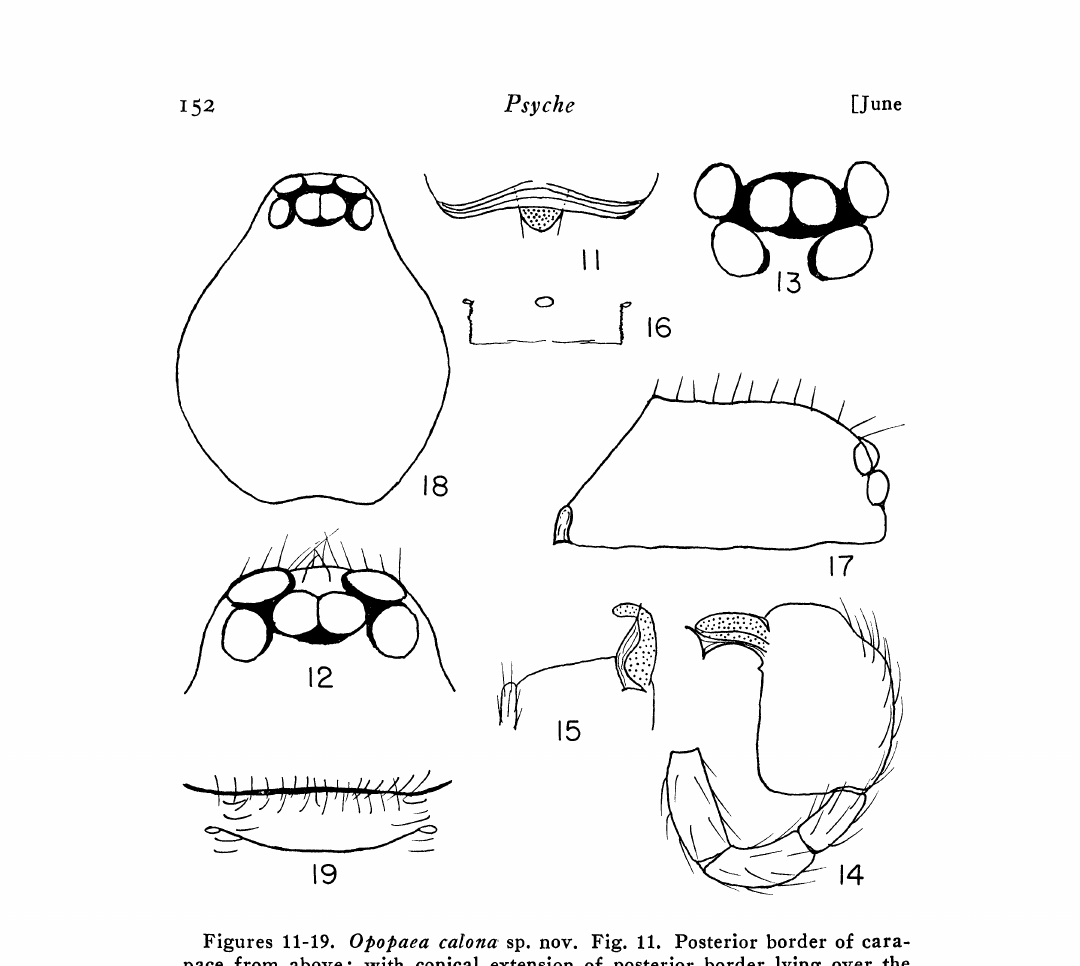
Figures 11-19. Opopaea calona sp. nov. Fig. 11. Posterior border of cara- pace from above; with conical extension of posterior border lying over the pedicel. Figs. 12-13. Eyes of male holotype from above and from in front, respectively. Fig. 14. Left male palp; retrolateral view. Fig 15. Tip of left male palpal tarsus; nearly ventral view. Fig. 16. Genital area of male holotype. Fig. 17. Carapace of described female paratype; right lateral view. Fig. 18. Carapace of female from above. Fig. 19. Epigynal area of female paratype from